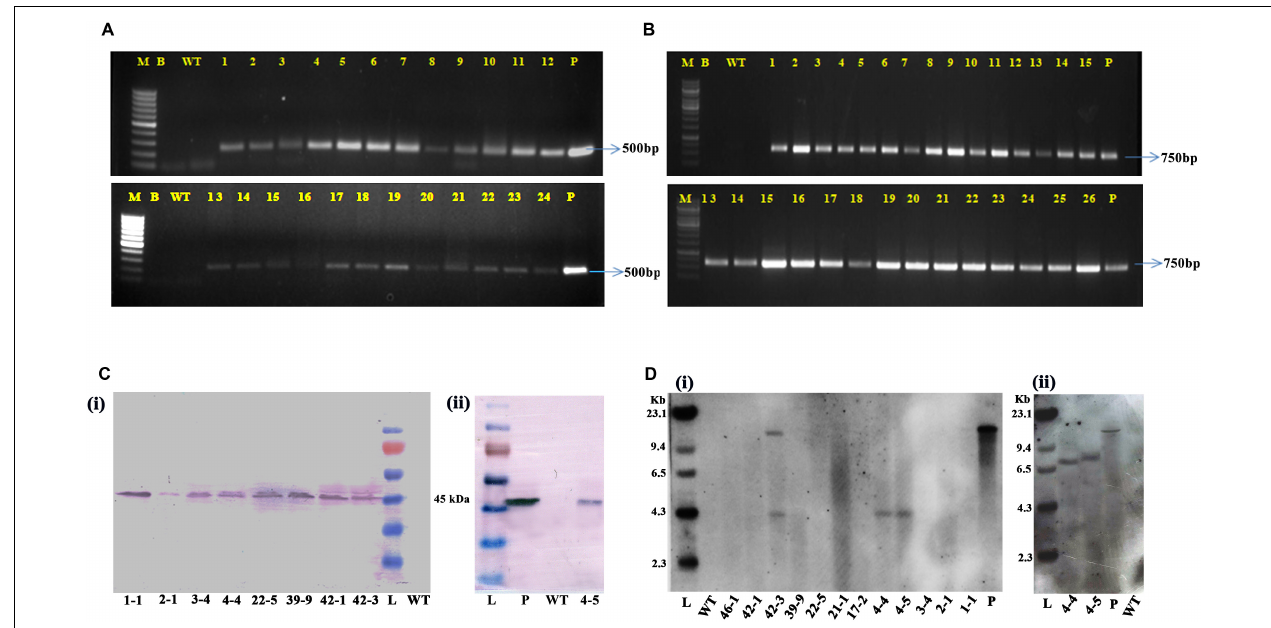
FIGURE 4 | Molecular analysis of transformants in T1 generation. Polymerase chain reaction analysis of T1 generation plants for the amplification of panel (A) 500-bp right border region of T-DNA. (B) 750-bp nptII fragment. Lane M: 1 kb Ladder (Thermo Fisher Scientific); Lane B: Water Blank (all PCR components but without template DNA); Lane WT: wild type; Lanes 1–24 of panel (A) and 1–26 of panel (B): T1 generation transgenic plants; Lane P: positive control (modified CP4-EPSPS binary vector). (C) Western blot analysis of selected transgenic plants along with wild type. (i) Lanes 1–8: transgenic plants (1-1, 2-1, 3-4, 4-4, 22-5, 39-9, 42-1, 42-3). Lane L: Prestained protein ladder; Lane WT: wild type; (ii) Lane L: prestained protein ladder; Lane P: purified protein of CP4-EPSPS (30 ng); Lane WT: wild type; Lane 4: transgenic plant 4-5. (D) Genomic Southern analysis of T1 generation transgenic plants. (i) Hin dIII digested genomic DNA probed with DIG-labeled 750-bp nptII fragment. Lane L: Lambda DNA Hin dIII digest; Lane WT: wild-type DNA; Lanes 3–14: DNA of transgenic plants (46-1, 42-1, 42-3, 39-9, 22-5, 21-1, 17-2, 4-4, 4-5, 3-4, 2-1, 1-1); Lane P: positive control (10 pg DNA of modified CP4-EPSPS binary vector). (ii) Bam HI digested genomic DNA probed with 420-bp CP4-EPSPS gene specific fragment. Lane L: Lambda DNA Hin dIII digest; Lane 2: 4-4; Lane 3: 4-5; Lane 4: positive control (10-pg modified CP4-EPSPS vector DNA); Lane 5: wild-type